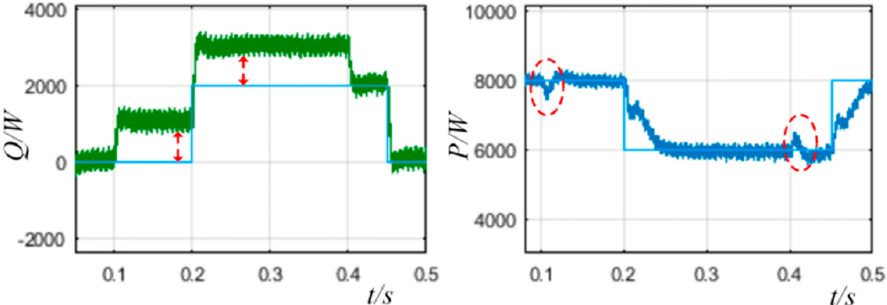
Figure 9. Active and reactive power under grid voltage frequency fluctuation with conventional droop control strategy.